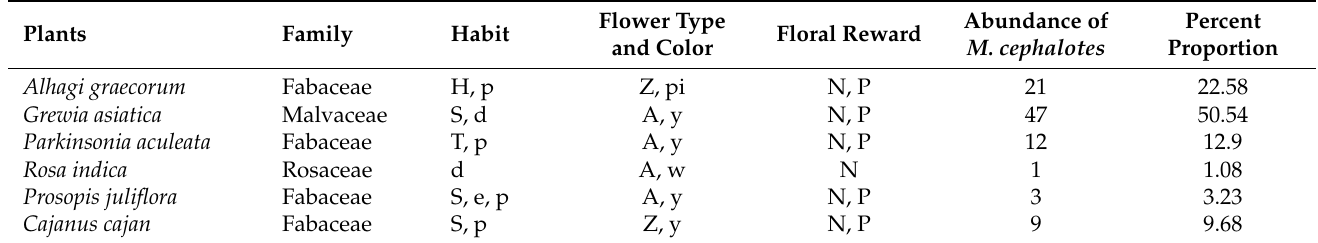
Table 5. Floral host plants visited by Megachile cephalotes